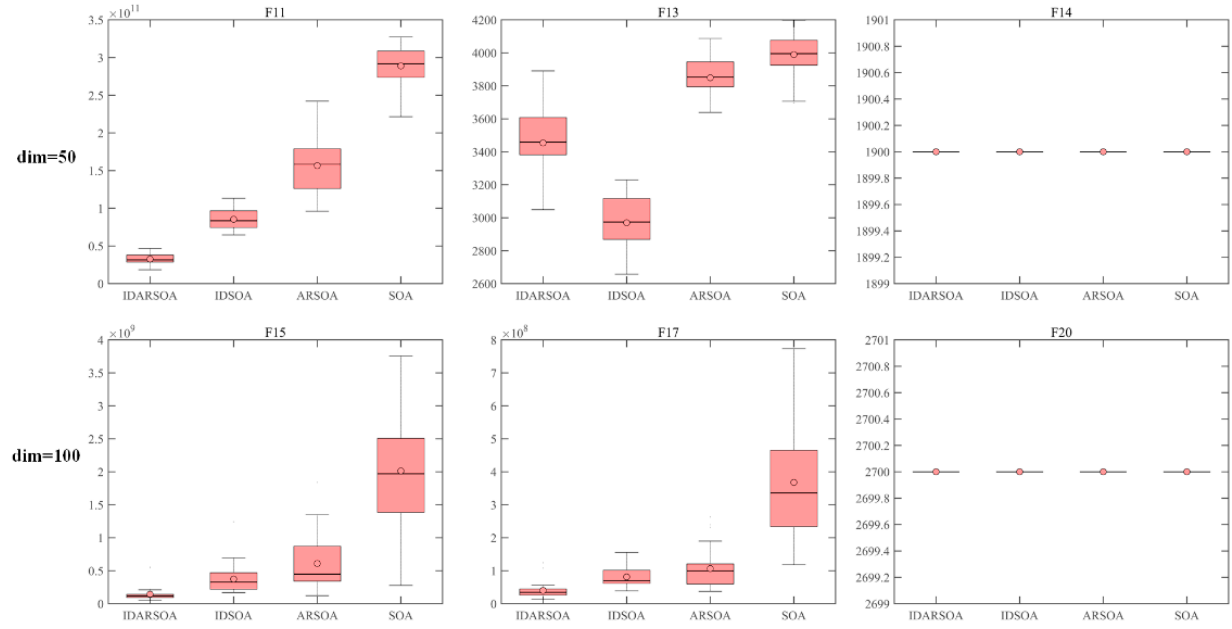
Figure 3. Box plots of SOAs.